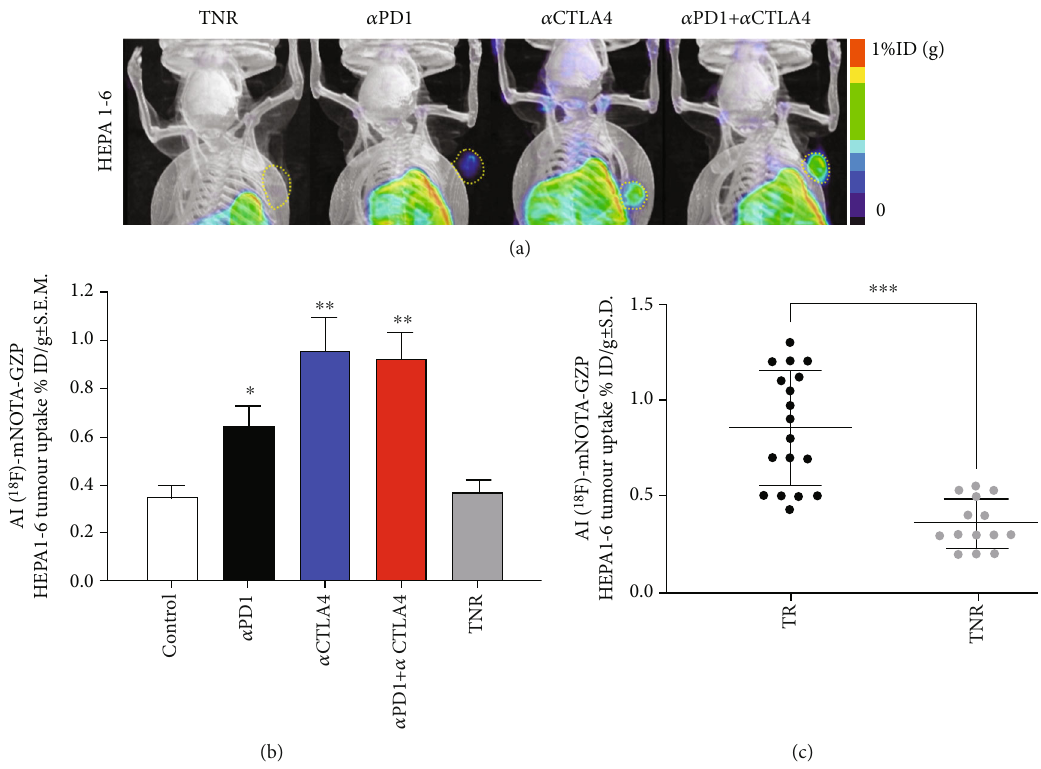
Figure 2: (a) Maximum intensity projection images depicting [ 18 F]AlF-NOTA-GZP tumour retention. Yellow dotted areas indicate the HEPA 1-6 tumour border. Mice were injected with [ 18 F]AlF-NOTA-GZP ( ~ 10 MBq intravenously) and static images acquired from 60- 80 mins postinjection. (b) Graph showing di ff erences in [ 18 F]AlF-NOTA-GZP tumour retention from each treatment arm. [ 18 F]AlF- NOTA-GZP tumour retention was signi fi cantly increased in α PD-1, α CTLA4 and combined α PD1 + α CTLA4 treatment arms when compared to treated nonresponders (TNR, n = 6 − 8 mice/group; ∗ P < 0 : 05 ; ∗∗ P < 0 : 01 comparing TR to TNR; data shown as mean % ID/ g ± S : E : M : ). (c) Individual values for [ 18 F]AlF-NOTA-GZP tumour retention in TRs and TNRs ( ∗∗∗ P < 0 : 001 , data shown as individual %ID/g). Table 1: Table showing HEPA 1-6 tumour retention of [ 18 F]AlF- NOTA-GZP after completion of ICI treatment. Data are shown as mean % ID/g ± S : D : and are separated into control, treatment responders (TR), and treatment nonresponders (TNR) ( n = 10 mice/group; ∗ P < 0 : 05 ; ∗∗ P < 0 : 01 , comparing TR to